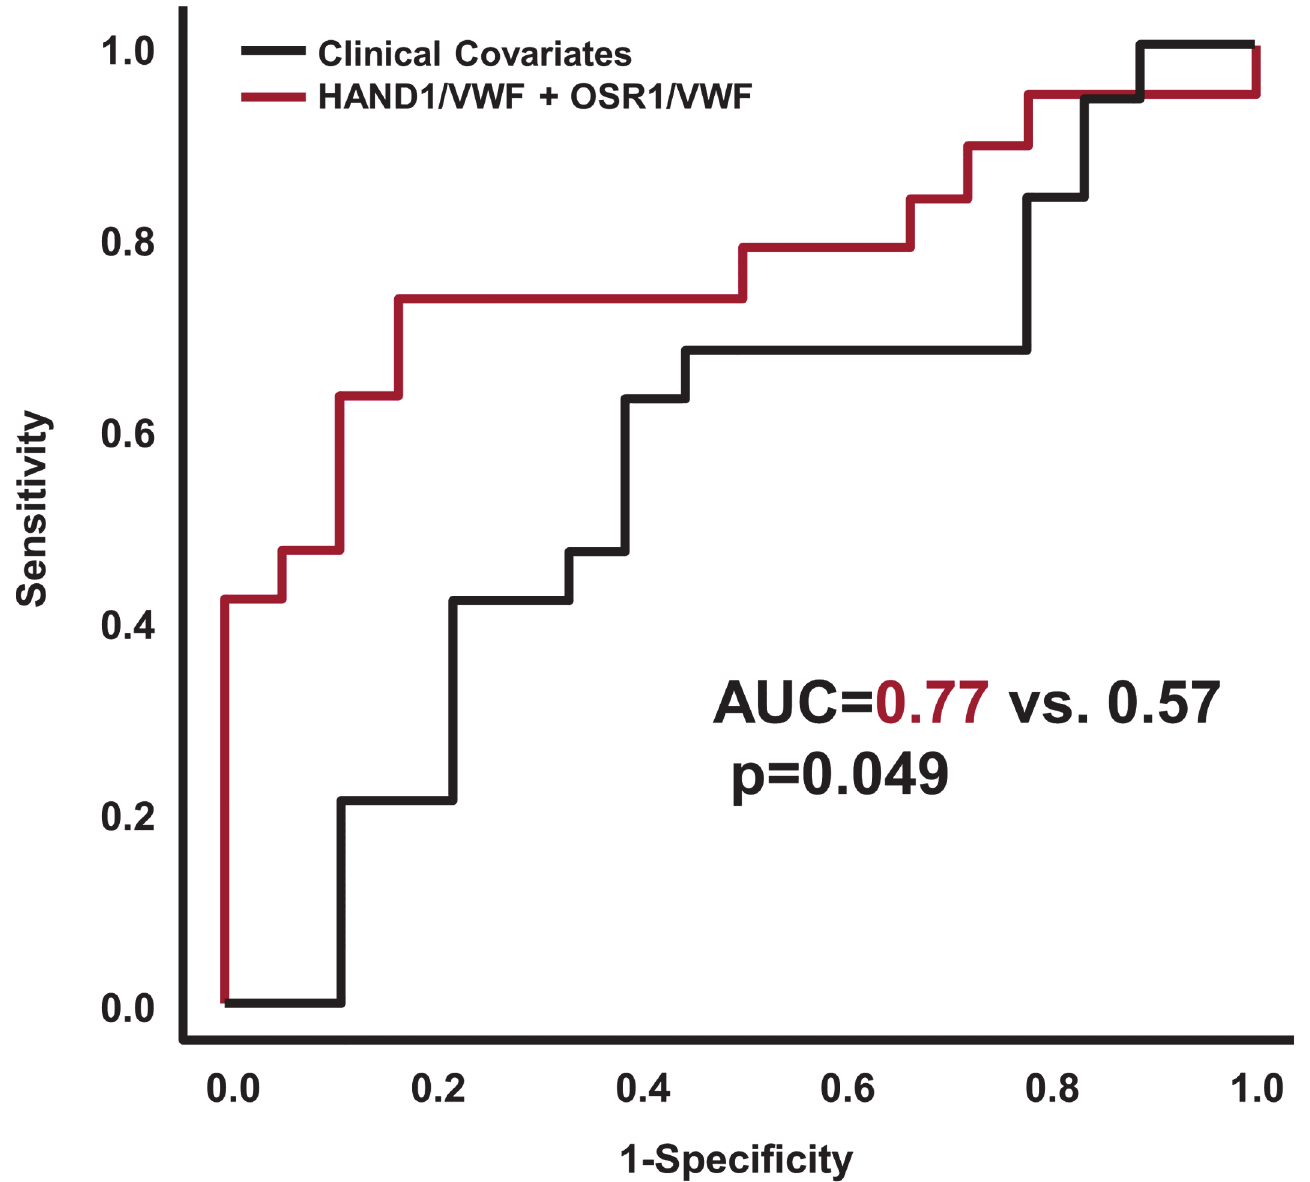
Fig 4. Performance of gene expression-based classifier on test set compared with a model using clinical covariates. When compared with clinical covariates available at the time of birth, the molecular prediction model had superior Area under the Receiver Operating Characteristic curve (AUC 0.77 vs 0.57, p = 0.049). Clinical covariates included the following: gestational age, gender, small for gestational age status, 5-minute Apgar score, labor and chorioamnionitis. The p-value for the difference between the two ROC curves was obtained using a bootstrap based method implemented in the pROC package in R